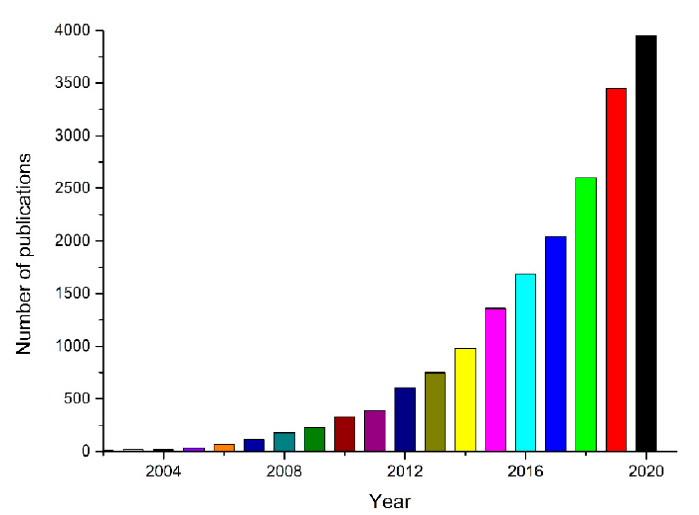
Figure 1. The number of publications in the 2002–2020 time period whose titles or keywords contain “MOF”. Data from Web of Science.